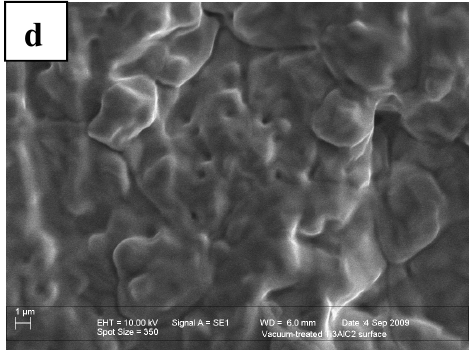
Figure 1. Scanning electron micrographs of the surface microstructures of vacuum-decomposed MAX phases; ( a ) Ti 2 AlN, ( b ) Ti 4 AlN 3 , ( c ) Ti 3 SiC 2 , and ( d ) Ti 3 AlC 2 (bulk) Courtesy of AZom.com [10]. Table 2. Comparison of the Avrami decomposition kinetics in MAX phases. Courtesy of AZom. com